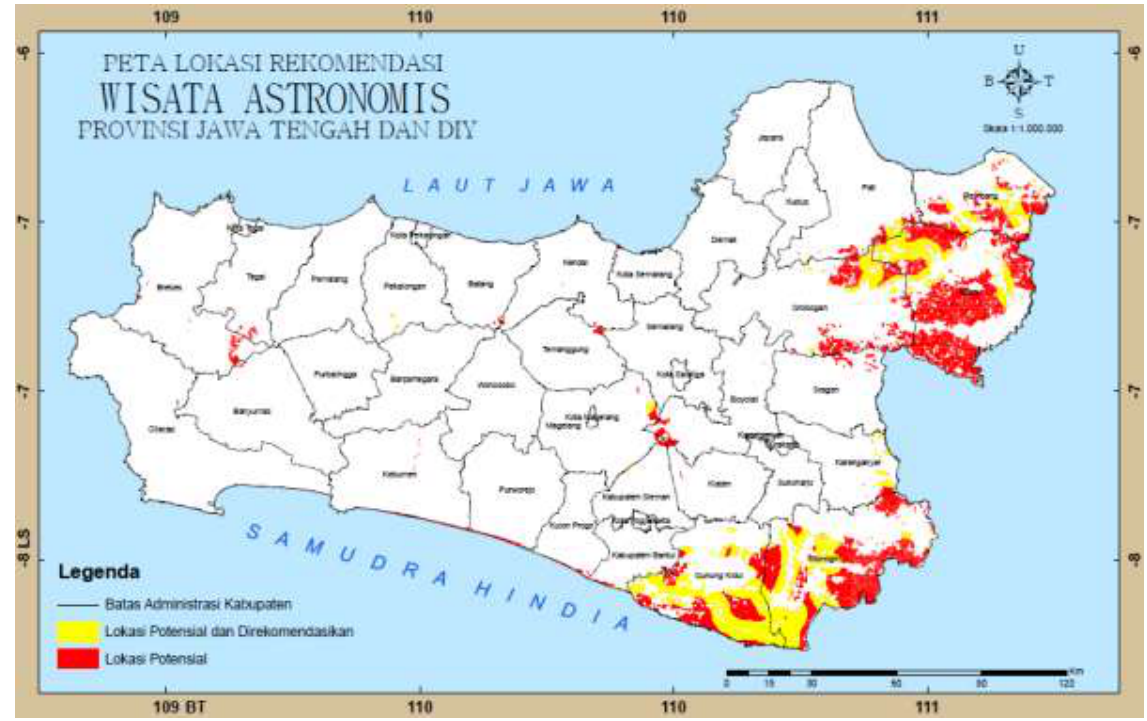
Figure 4. Distribution of Astronomical Tourism Maps (Source: Afrizal dkk.,